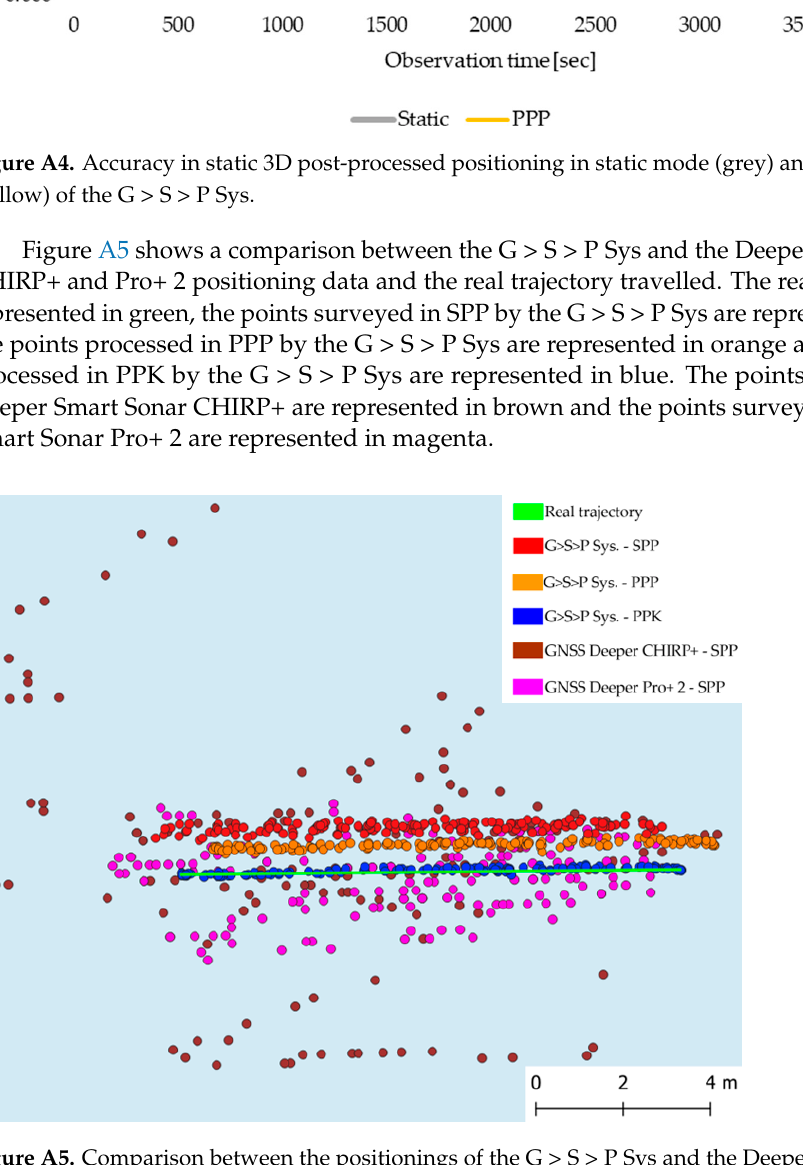
Figure A5. Comparison between the positionings of the G > S > P Sys and the Deeper Smart Sonars compared to the real trajectory in the sea test.